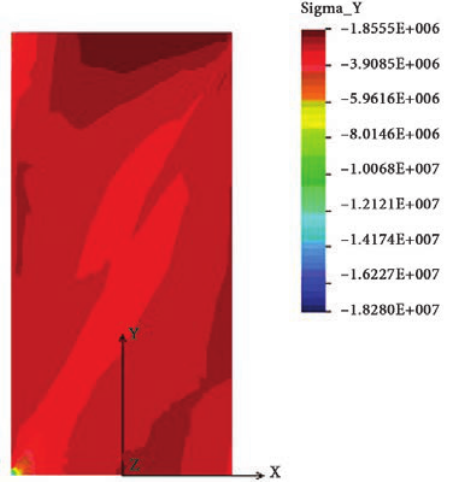
Fig. 10. Distribution of vertical component of stress s y in the sample with free ends